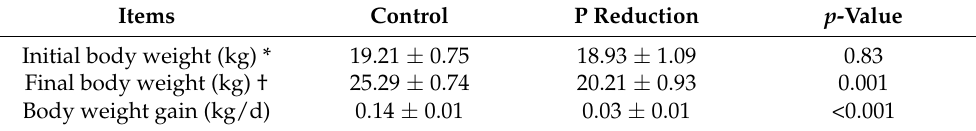
Table 2. Initial body weight and effects of a low phosphorus (P) diet on body weight gain and final body weight of young goats fed a low P diet. (Mean values with their standard errors; n = 7 animals).